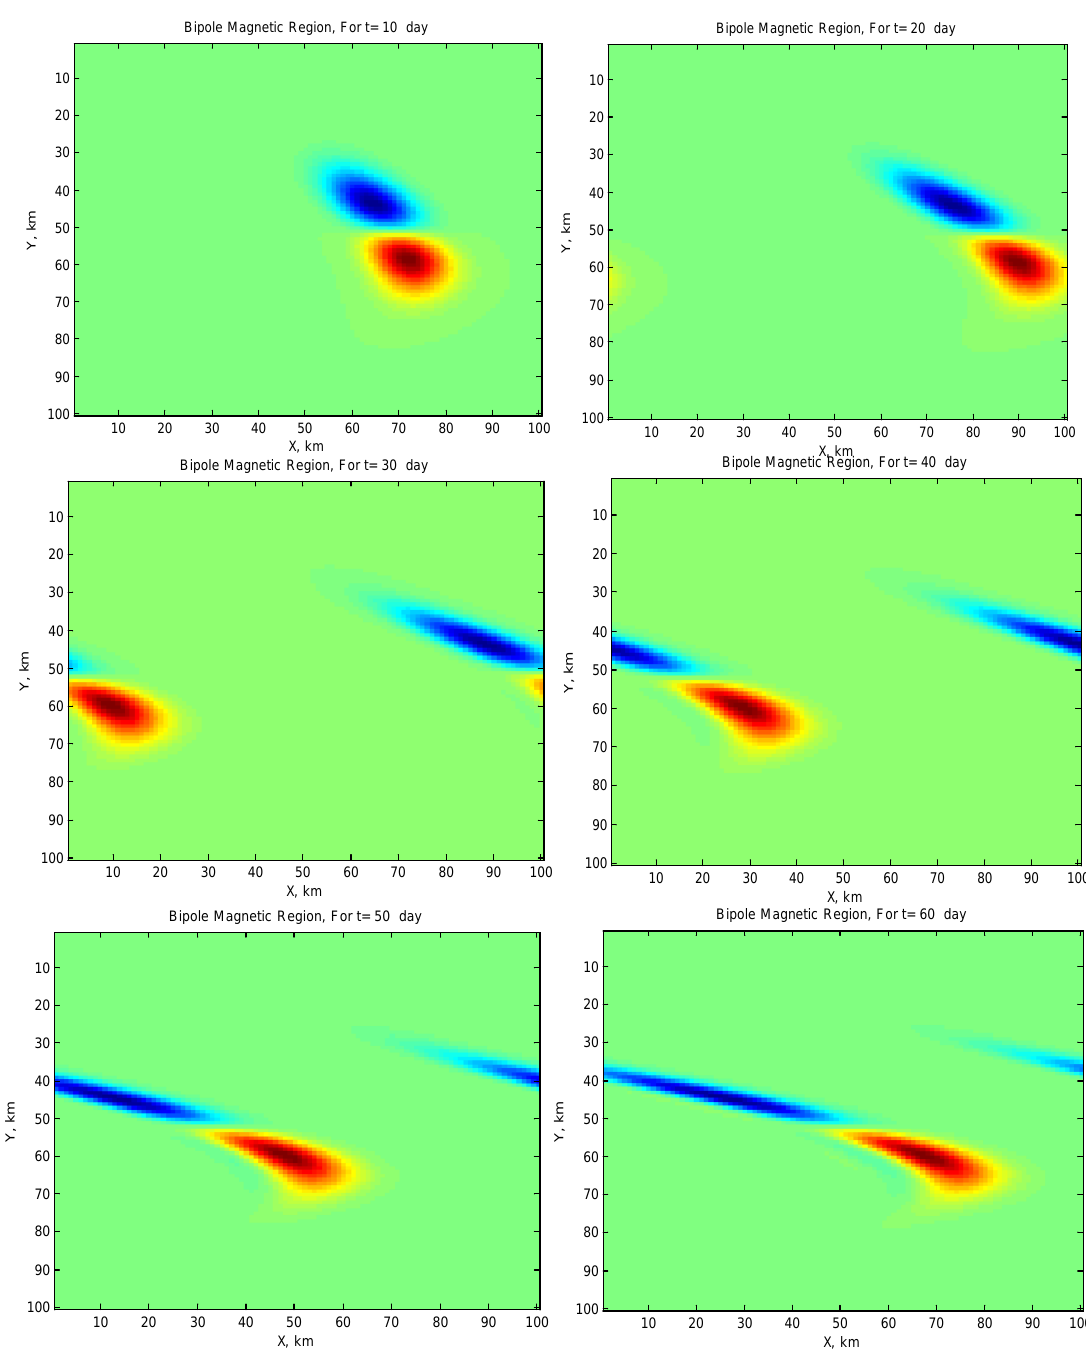
Fig. 8: Implicit numerical solution of equation of magnetic transport flux for many 60 days and